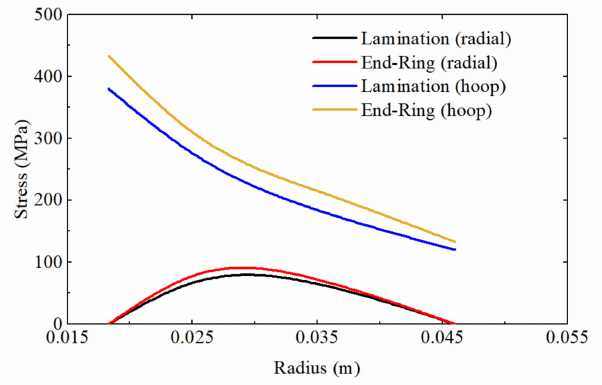
Figure 8. Lamination and end-ring stress calculated from rotating hollow disk